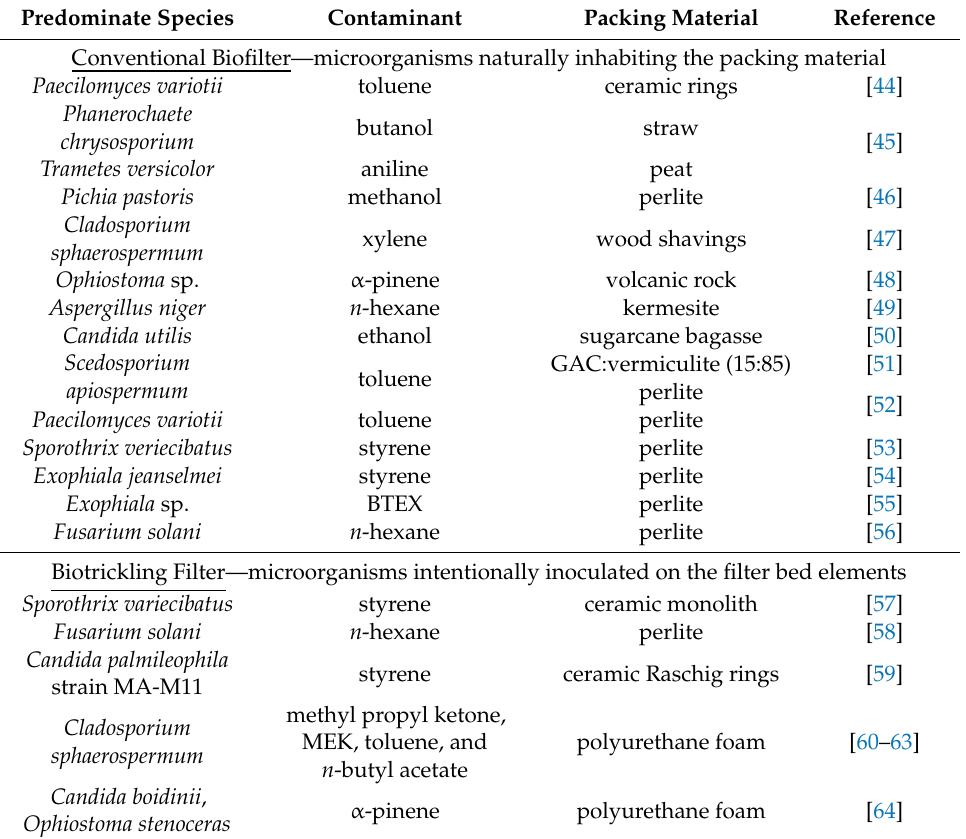
Table 1. Examples of fungi employed for gas purification in conventional biofiltration and biotrickling filtration